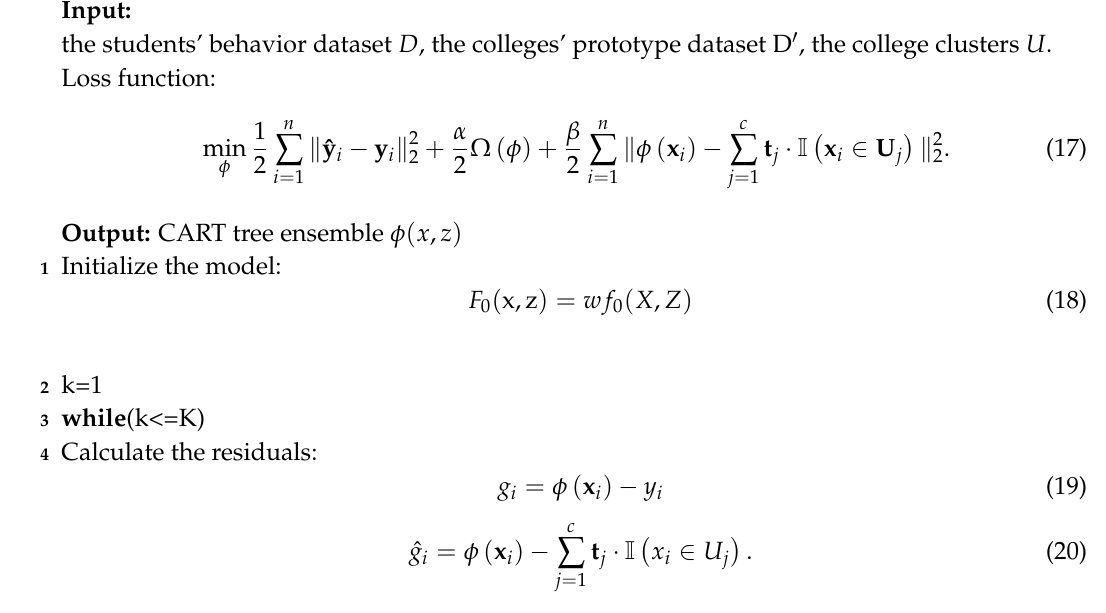
Algorithm 1: Iterative update of